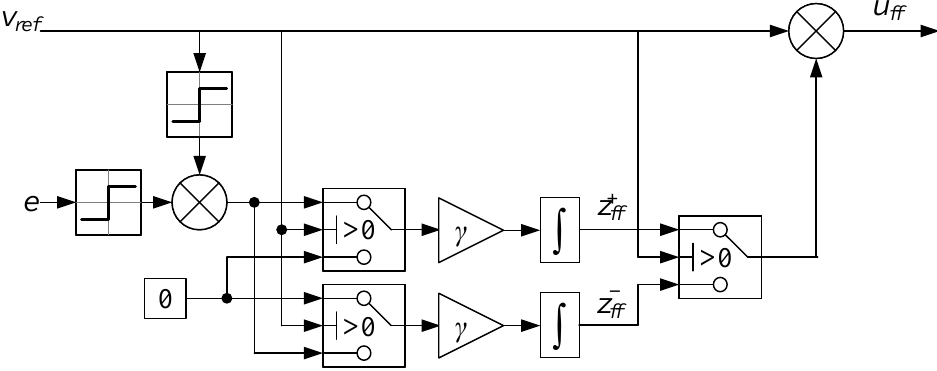
Figure 14. Differential sign-sign adaptive